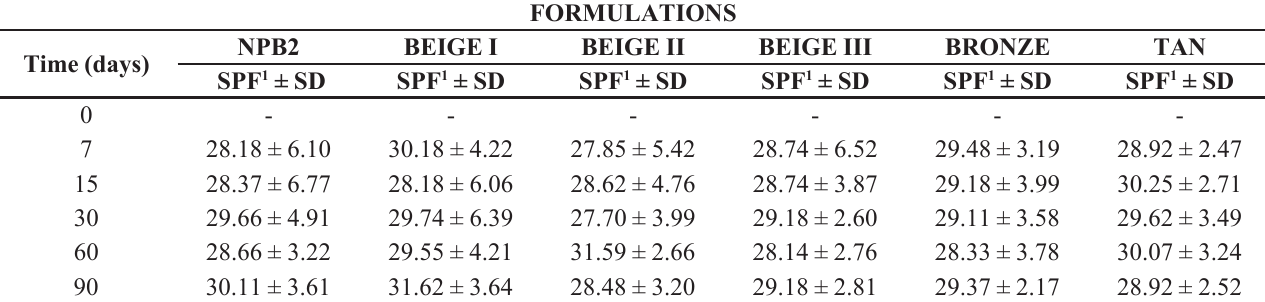
TABLE XV - Results of SPF variation tests of the NPB2 base and corrective makeup stored at 5.0 ± 2.0 ºC for up to 90